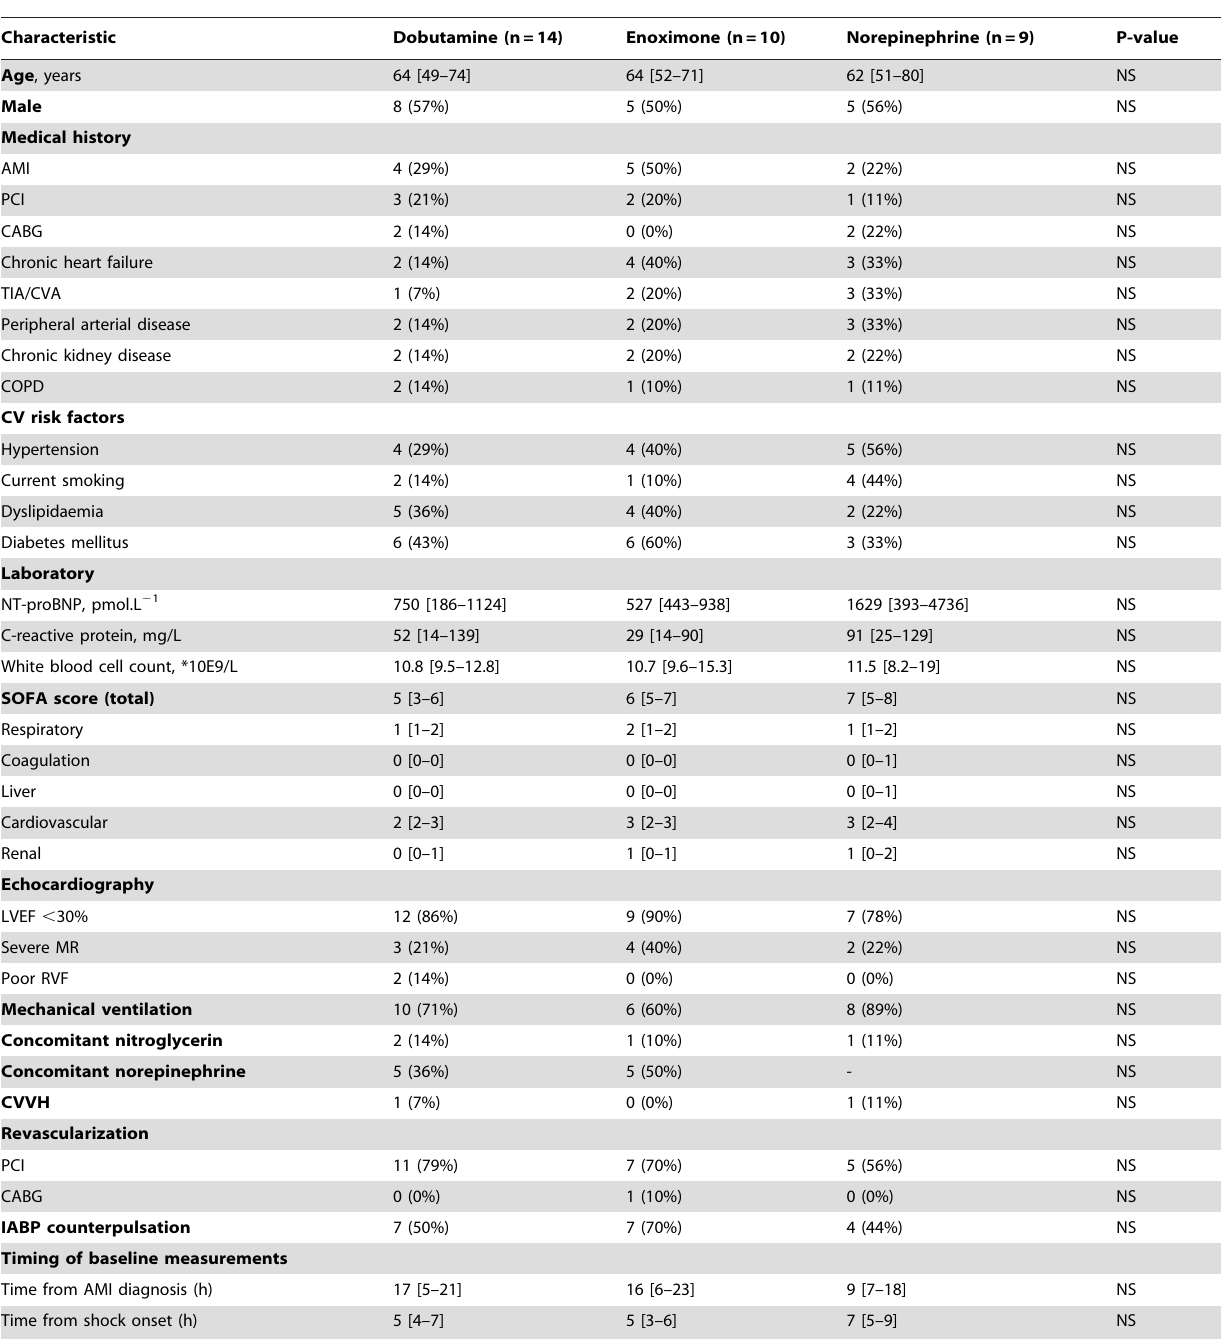
Table 1. Baseline characteristics of the study